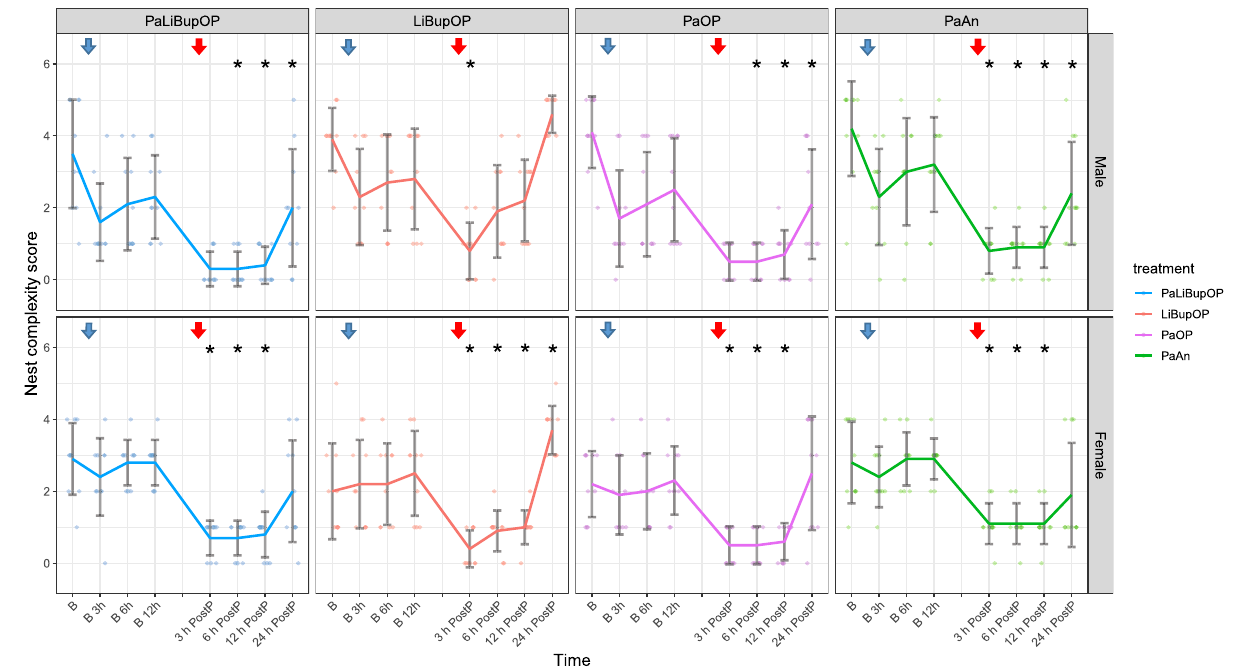
Figure 7. Nest complexity scores displayed for female and male mice for each treatment group. The blue arrow indicates that a new nestlet was provided for baseline measurements, the red arrow indicates the surgery/ anesthesia followed by the distribution of a new nestlet. Bonferroni post hoc testing detected no significant differences between the treatment groups at baseline level and 3 h post-procedure. Male LiBupOP had a significantly higher nest complexity score than PaLiBupOP and PaOP 6 and 12 h post-procedure; at 24 h post-procedure male LiBupOP had a significantly higher score than all other treatment groups. In female mice, 24 h post-procedure nest complexity in LiBupOP was significantly higher than in all other treatment groups. Significant differences to respective baseline measurements are indicated with *p ≤ 0.05, Dunnett’s post hoc. Data are shown as scatter dot plot with mean ± SD. Numbers per group: PaLiBupOP, LiBupOP, PaOP, and PaAn n = 10/per